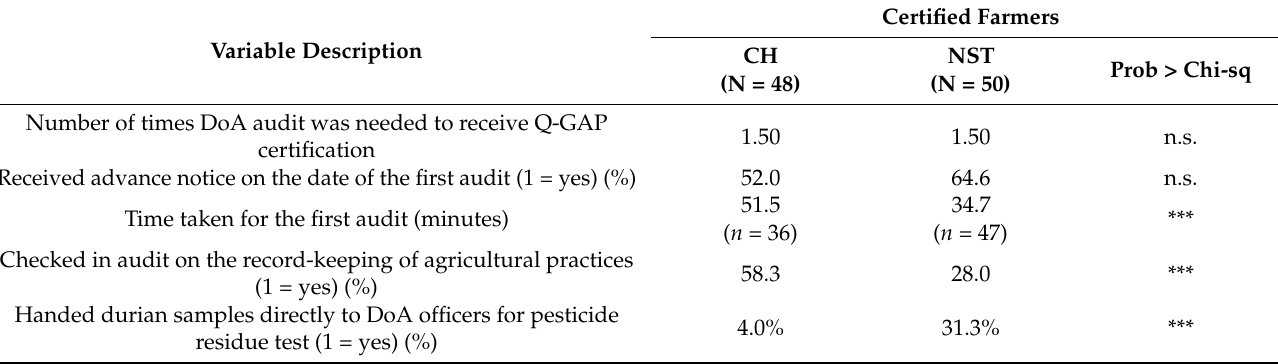
Table 7. Audit experiences of Q-GAP-certified